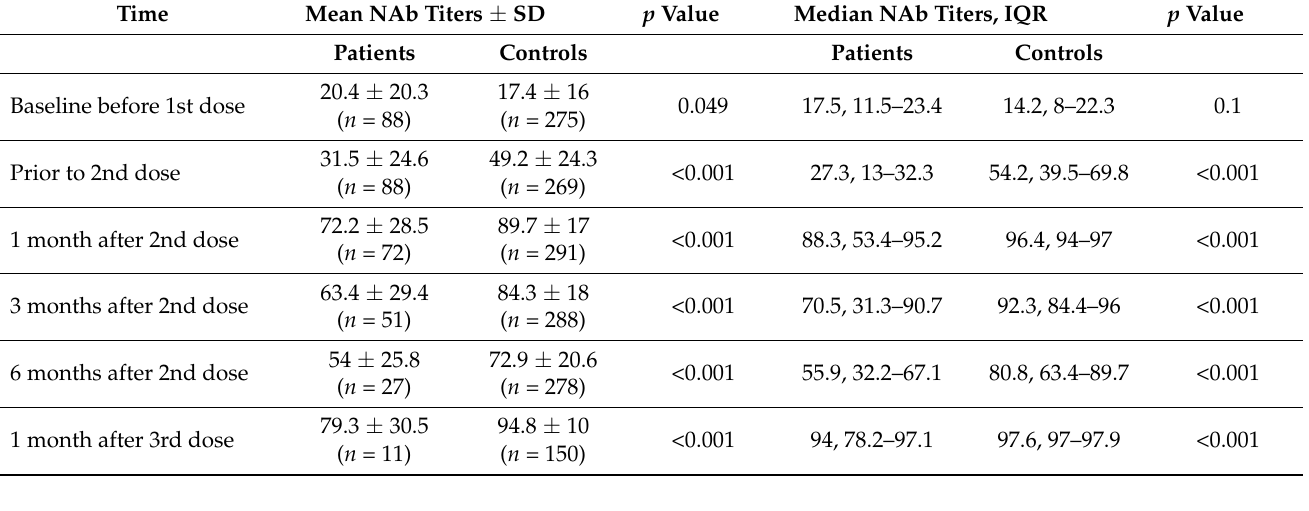
Table 2. Temporal trends of neutralizing antibody titers in patients and controls.